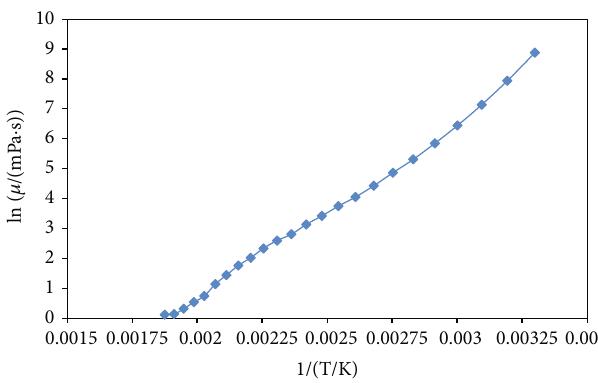
Figure 2: The viscosity-temperature curve of the heavy oil from L reservoir.